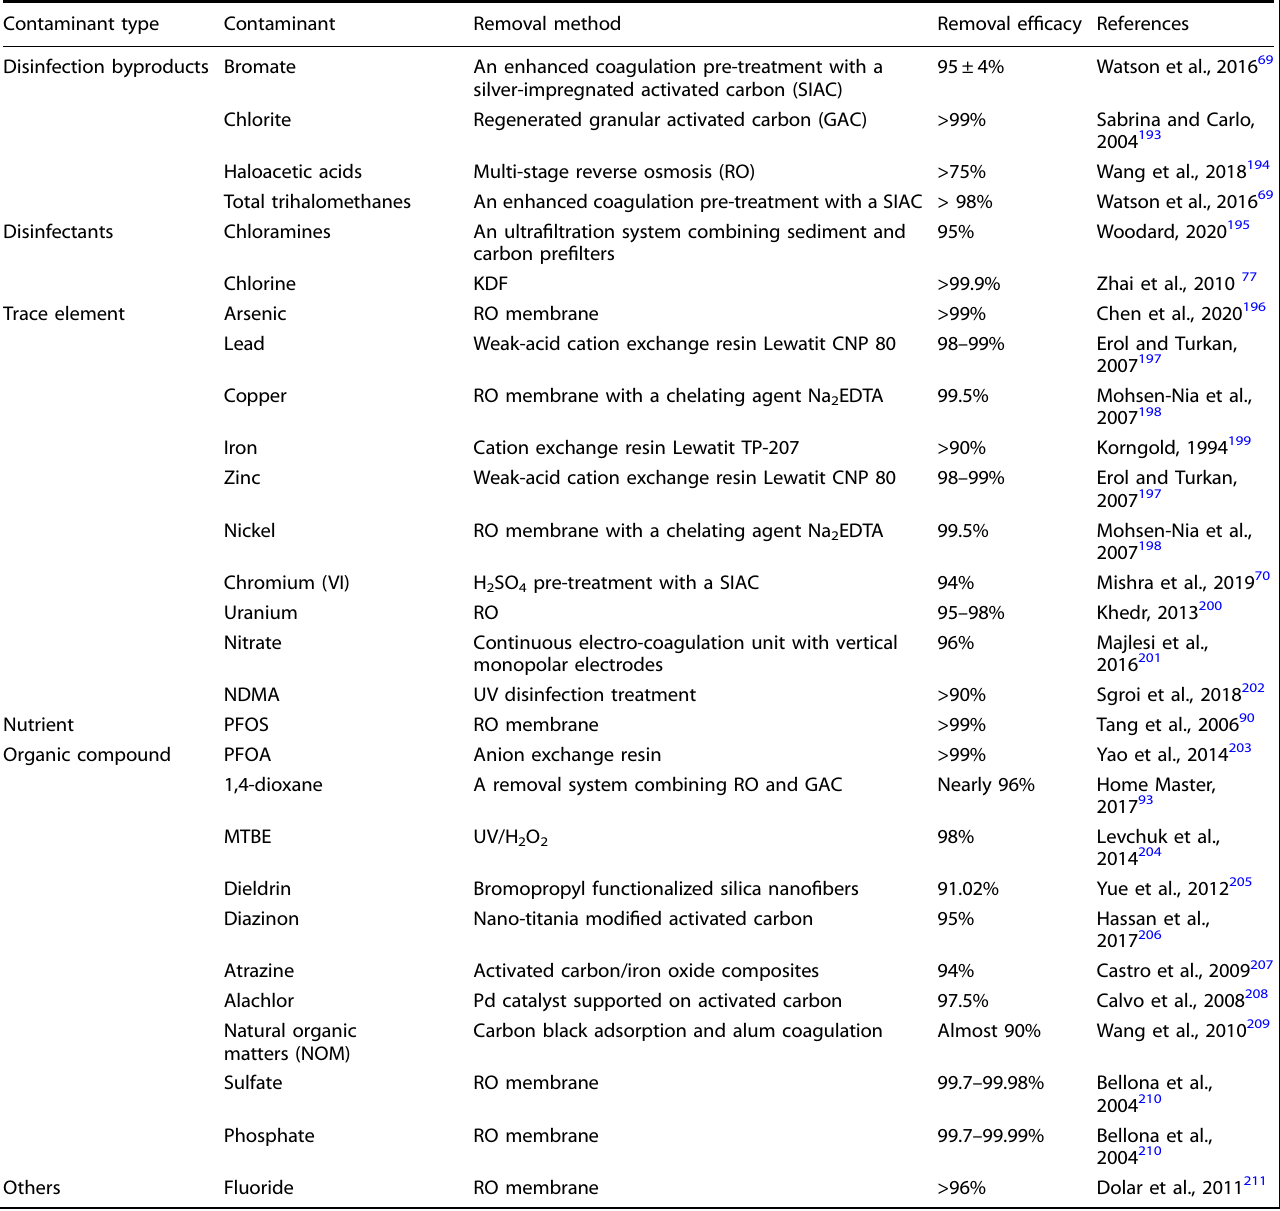
Table 11. Removal ef fi cacies summary of POU